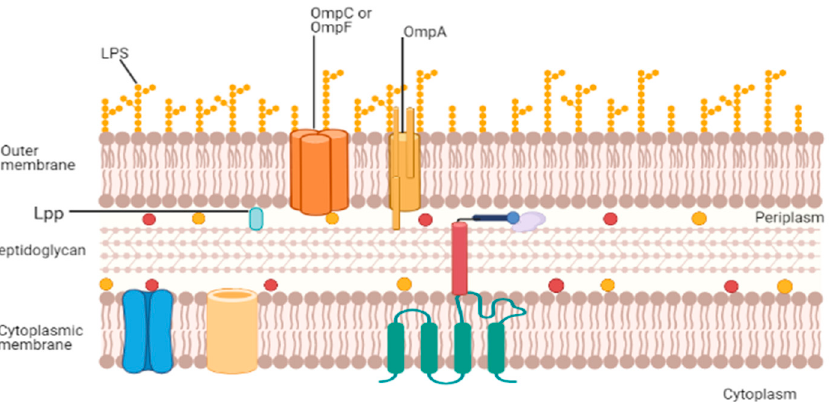
Figure 1. Composition of Gram-negative cell envelope [12]. LPS: lipopolysaccharides, Lpp: Braun’s lipoprotein, and OmpC/F/A: outer-membrane protein.